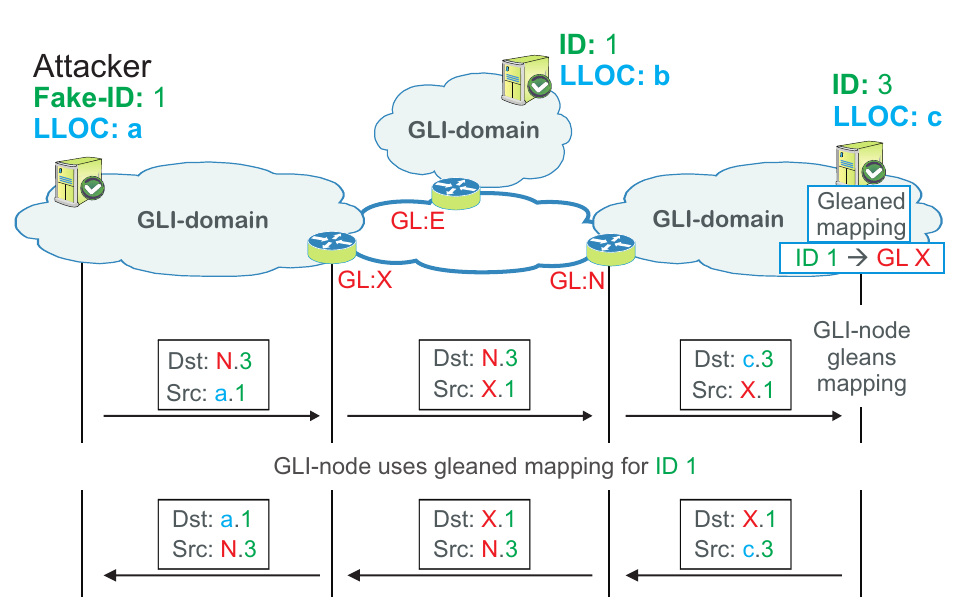
Figure 6. When a GLI-host gleans locators from incoming source addresses, a malicious node can send a packet with a spoofed source ID and steal traffic intended for that